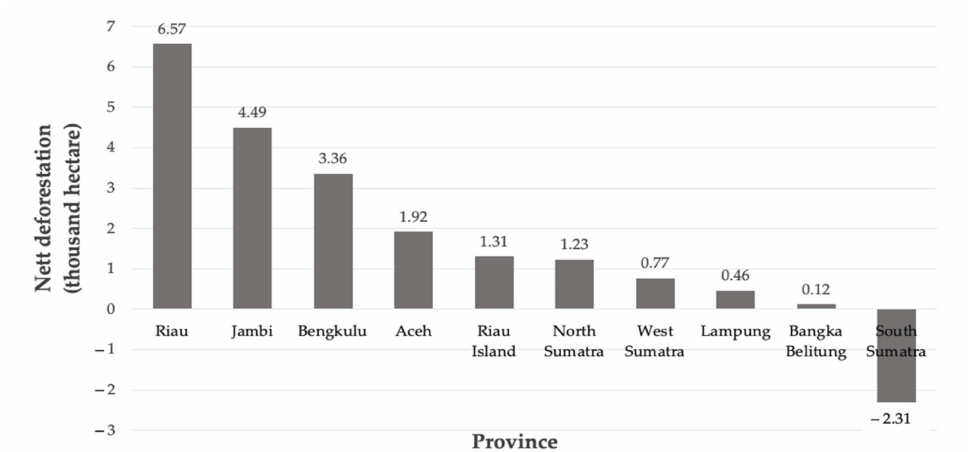
Figure 3. Indonesian deforestation trends in 1990–2019 [53].